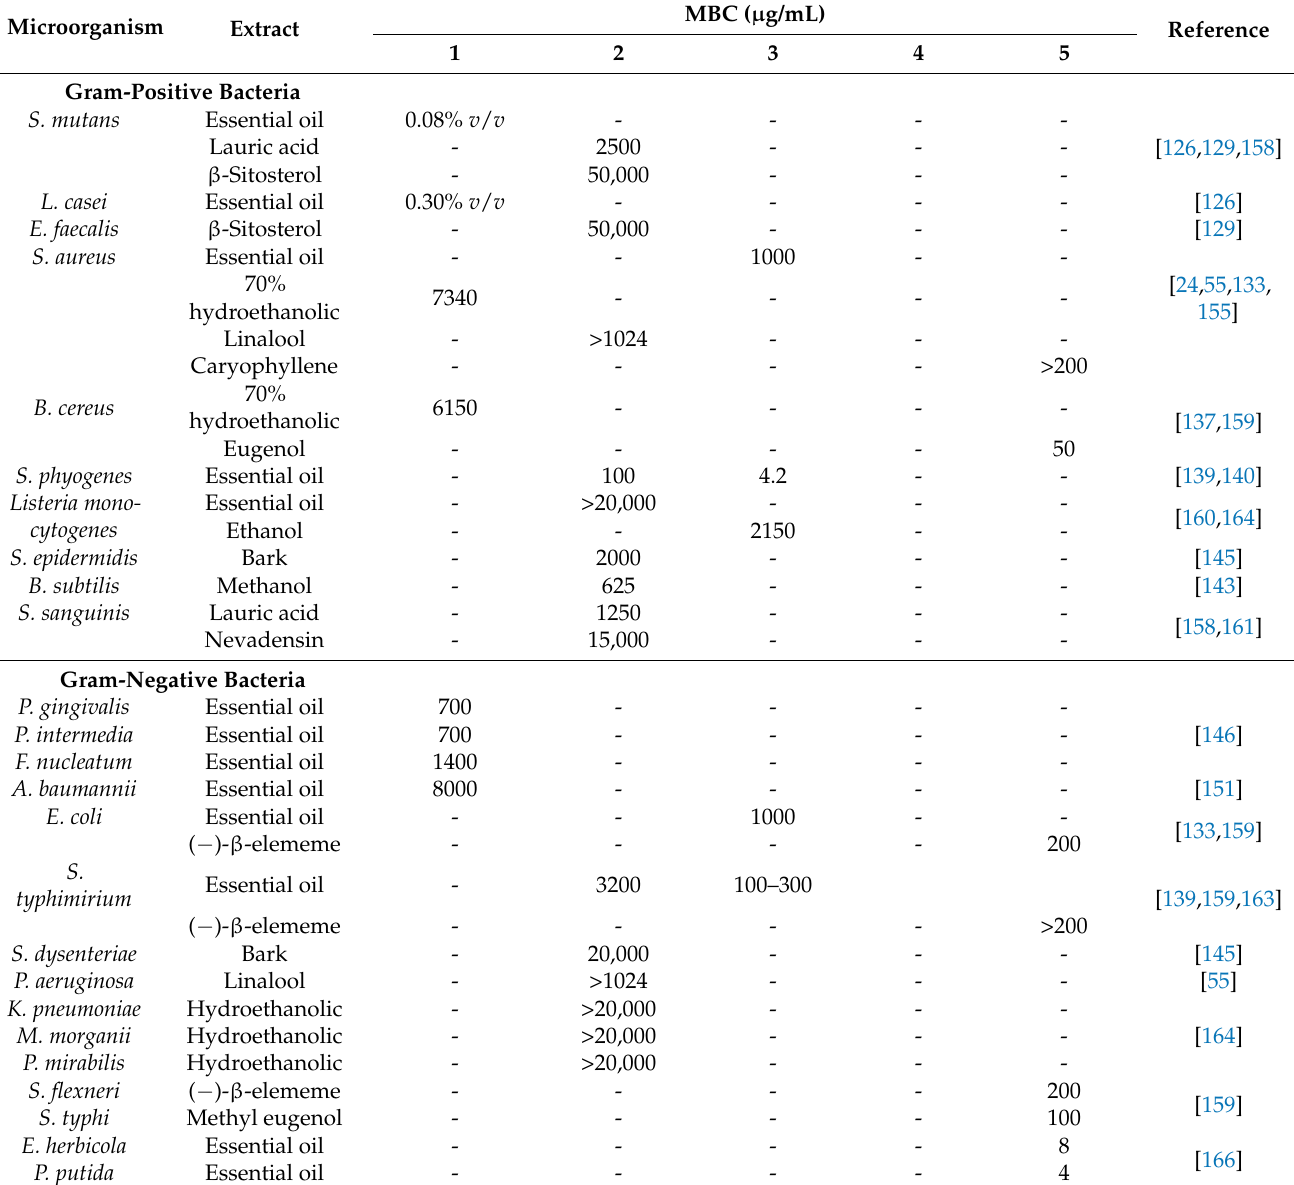
Table 8. Data of minimum bactericidal concentration (MBC) of Ocimum